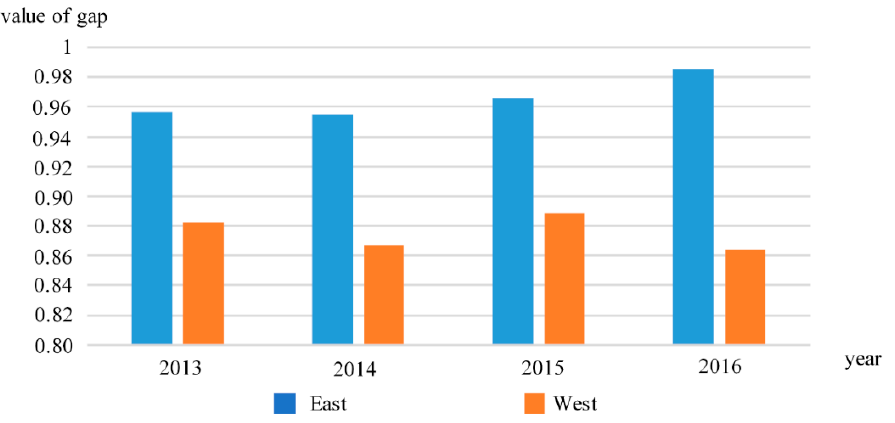
Figure 4. Regional efficiency gap comparison from 2013–2016.